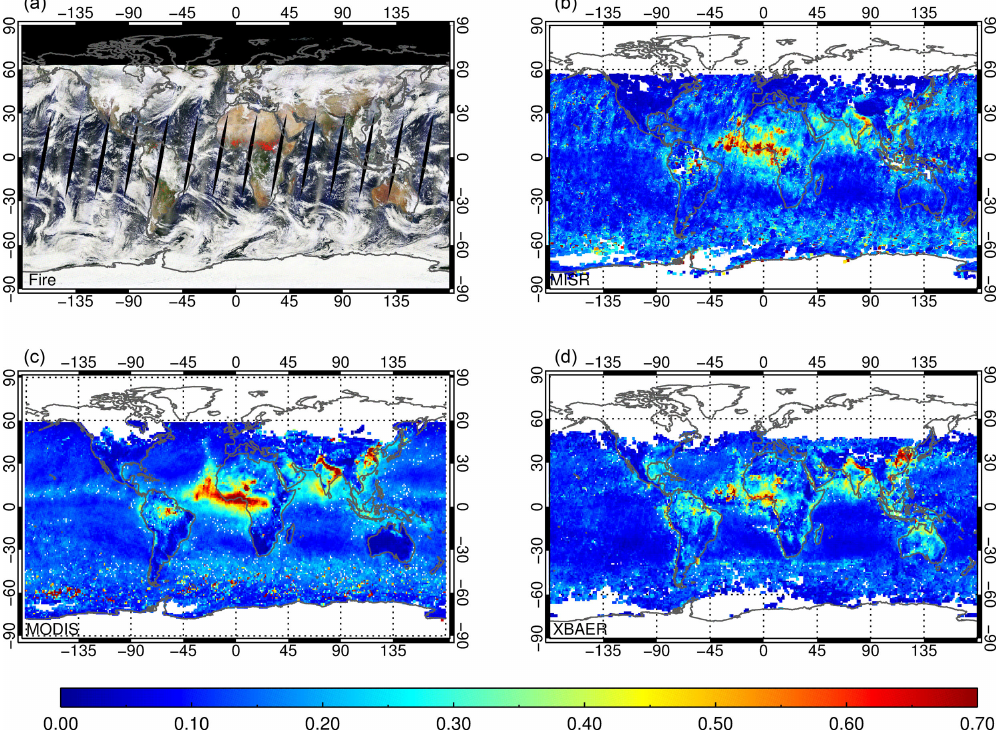
Figure 4. Comparison of the retrieved global monthly mean AOT at 0.55µm for December 2016. (a) MODIS fire product, (b) MISR, (c) MODIS (Dark-Target and DeepBlue combined), and (d) OLCI (XBAER).